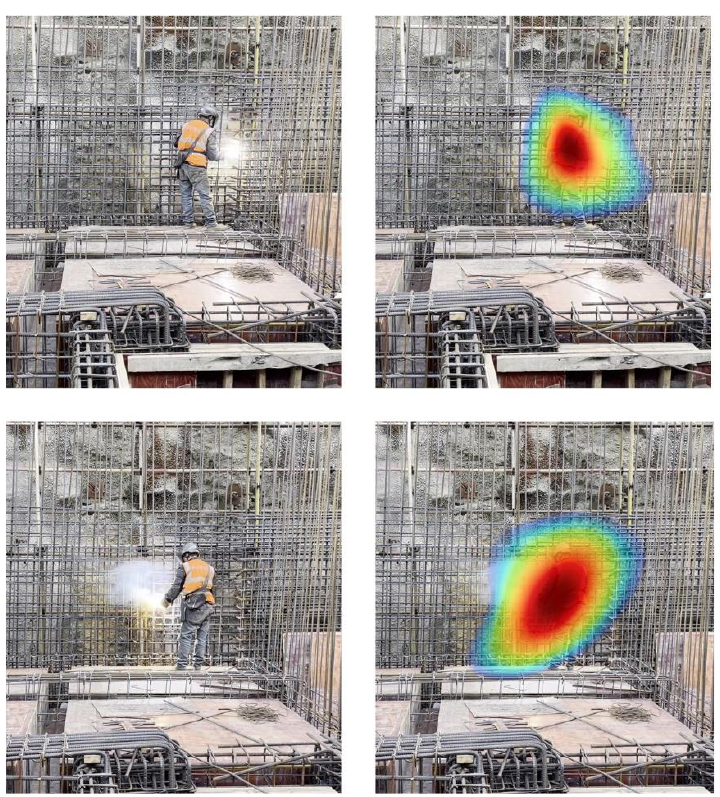
Figure 4. Experimental results of the construction site dataset.